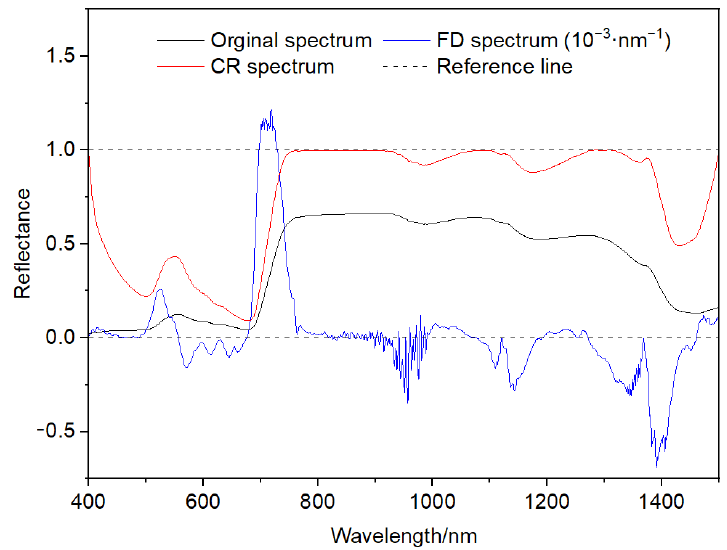
Figure 4. Characteristics of original spectrum, first-order differential (FD) spectrum and continuum removal (CR) spectrum of tree peony leaves.